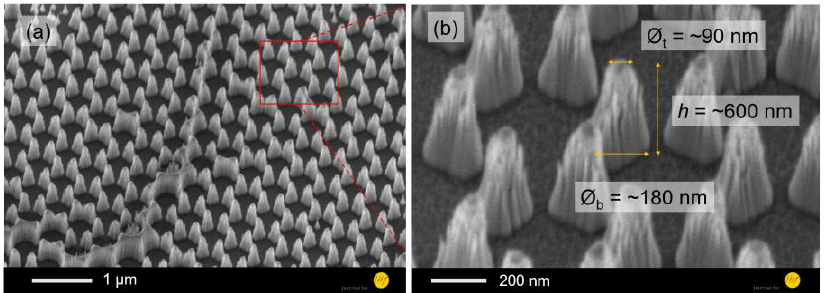
Figure 4. SEM images showing ( a ) GaN nanowires with a height of ~600 nm µm and ( b ) heavily rugged sidewalls due to the ion bombardment after ICP-DRIE process.